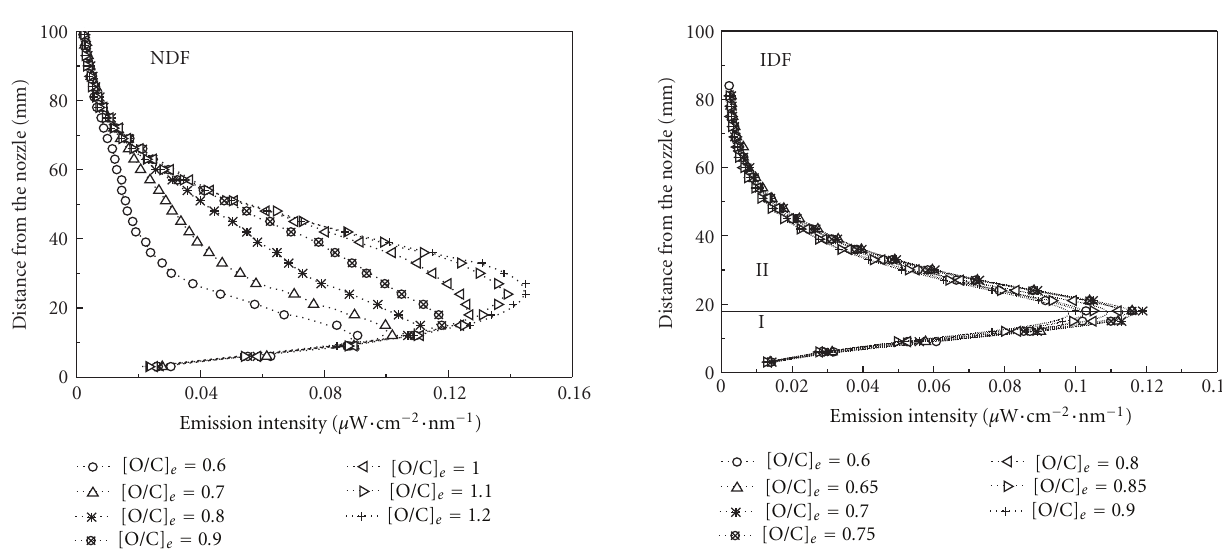
F 6: e change of OH for NDFs.